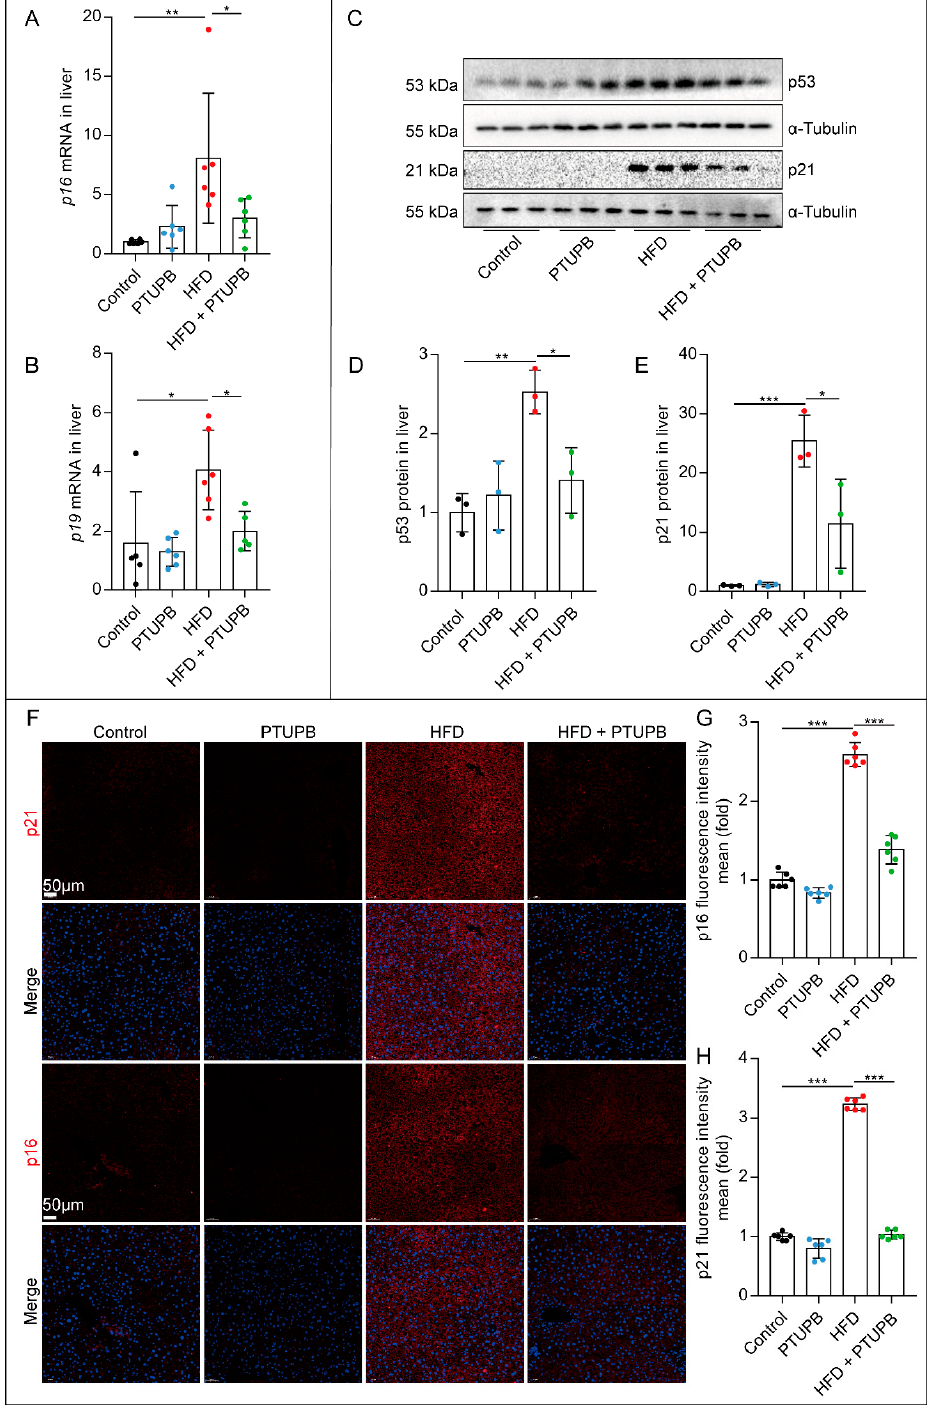
Figure 2. PTUPB inhibits hepatocyte senescence induced by HFD in mice. p16 and p19 mRNA ex- pressions in the liver were detected using real-time PCR (( A , B ), n = 5–6). Western blot was used to